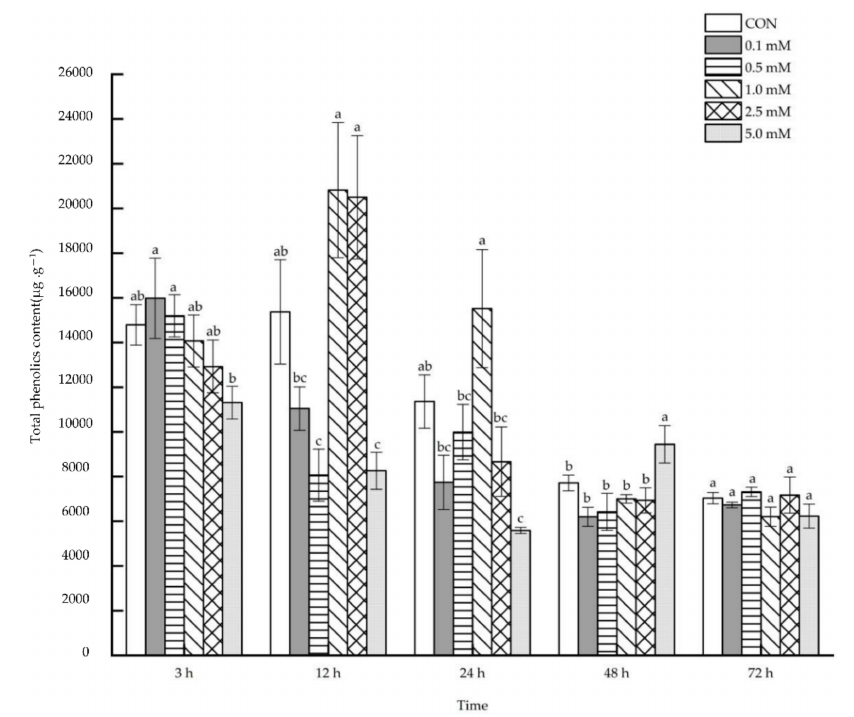
Figure 8. The systemic effect of the SA concentration and post-treatment time on the total phenolics content in roots following exogenous foliar application. The data are presented as mean ± standard errors. The significance of data was determined by the Duncan method. The difference between different letters at the same time reached significant levels of